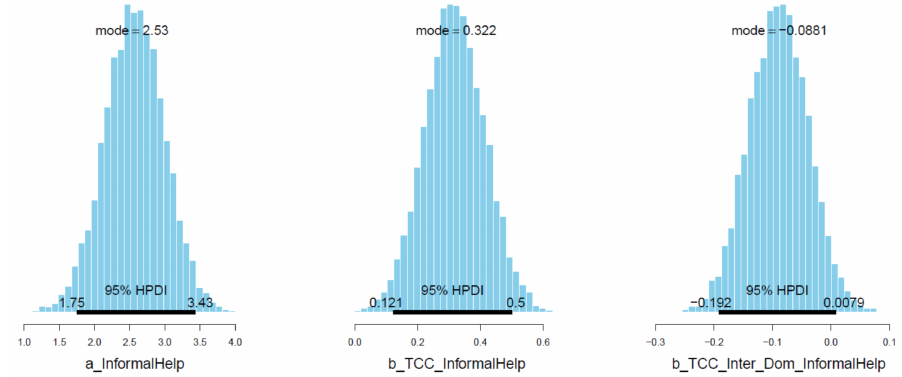
Figure 9. Distributions of Model 2 (cid:48) s posterior coefficients with HPDI at